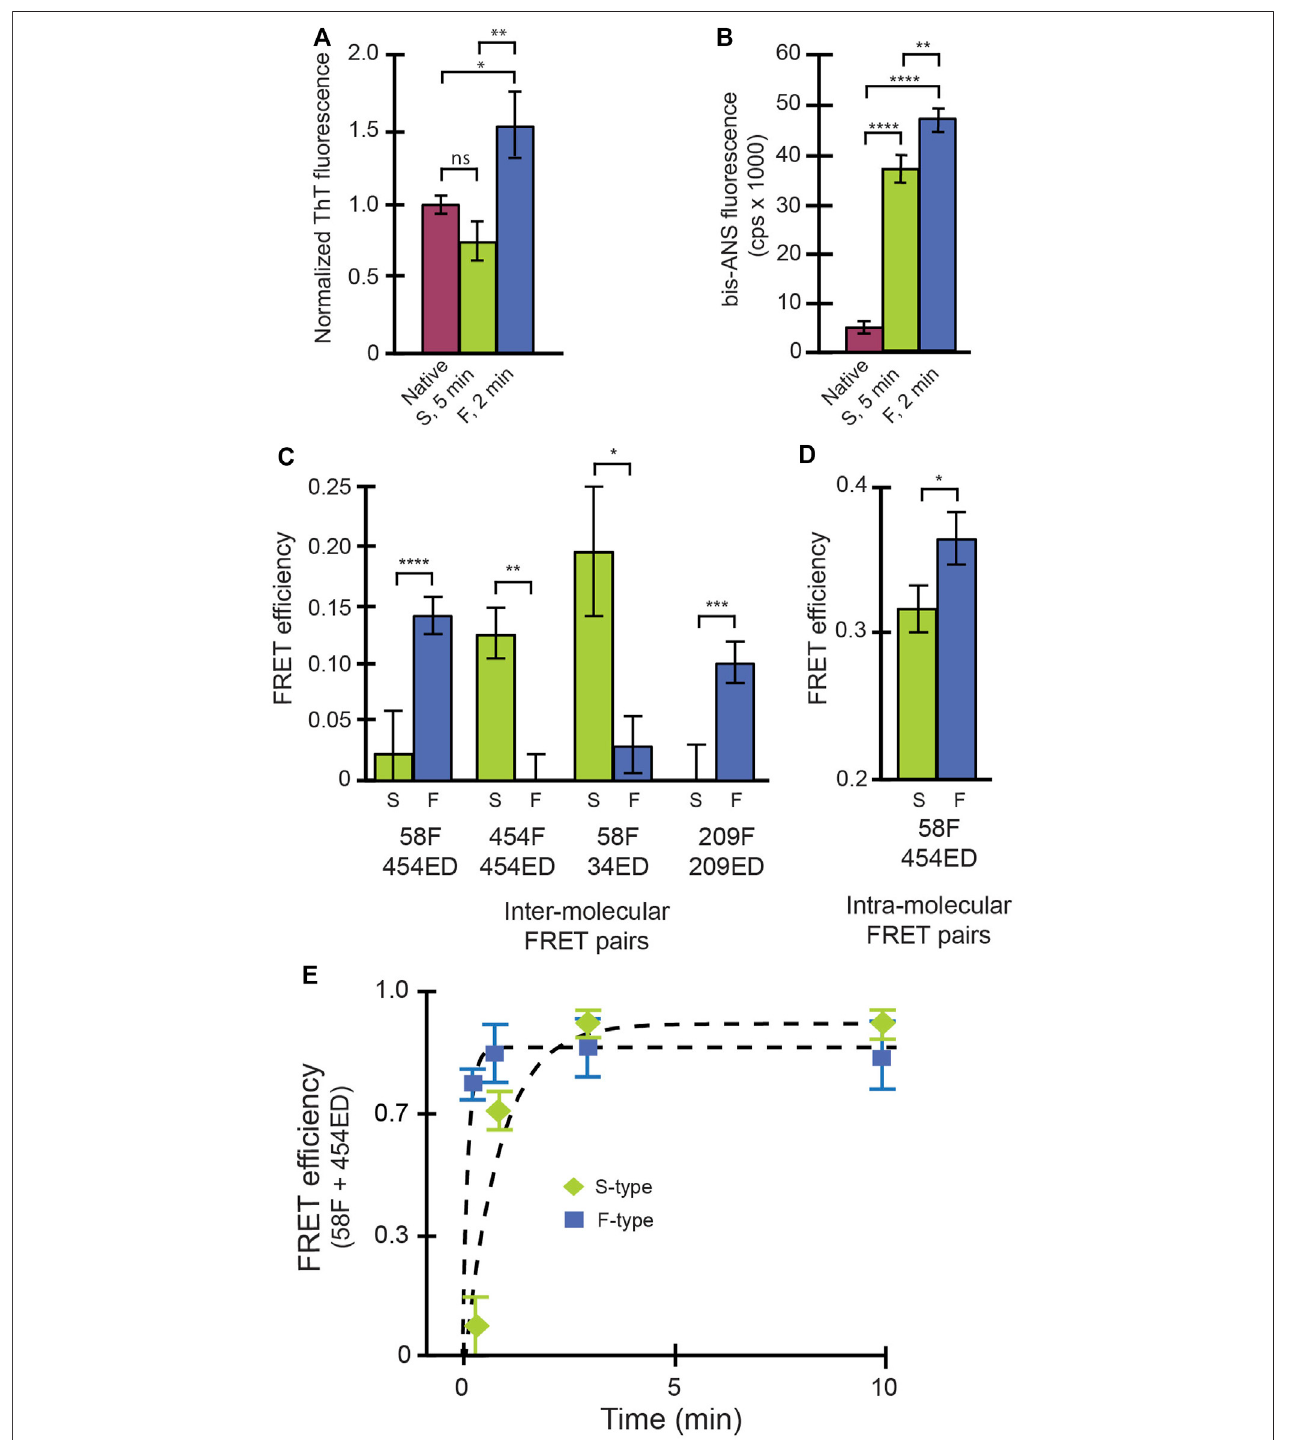
FIGURE 1 | Conformational signatures of slow-growing (S-type) and fast-growing (F-type) RuBisCO aggregates in free solution. (A) Thio fl avin T (ThT) binding to RuBisCO F-type aggregates ( “ F, ” blue), S-type aggregates ( “ S, ” green) and the native RuBisCO dimer (plum) is shown and provides an estimate of average beta sheet content (Sulatskaya et al., 2011). (B) Binding of bis-ANS, which provides an estimate of solvent accessible hydrophobic surface area (Rosen and Weber, 1969) of differentRuBisCOaggregatetypes,isshown. (C) Theaverageproximity ofRuBisCOmonomerswithindifferentaggregateswasexaminedusingasensitizedinter- molecularFörsterresonanceenergytransfer(FRET).Differentcombinationsoflabeledmonomerswereemployed,inwhichtheaminoacidpositionofthedonor( ED )and acceptor ( F ) probes (indicated by numbers) was shifted. In order to increase the sensitivity of the assay to differences in relative dye position, 1:1 mixtures of donor- and